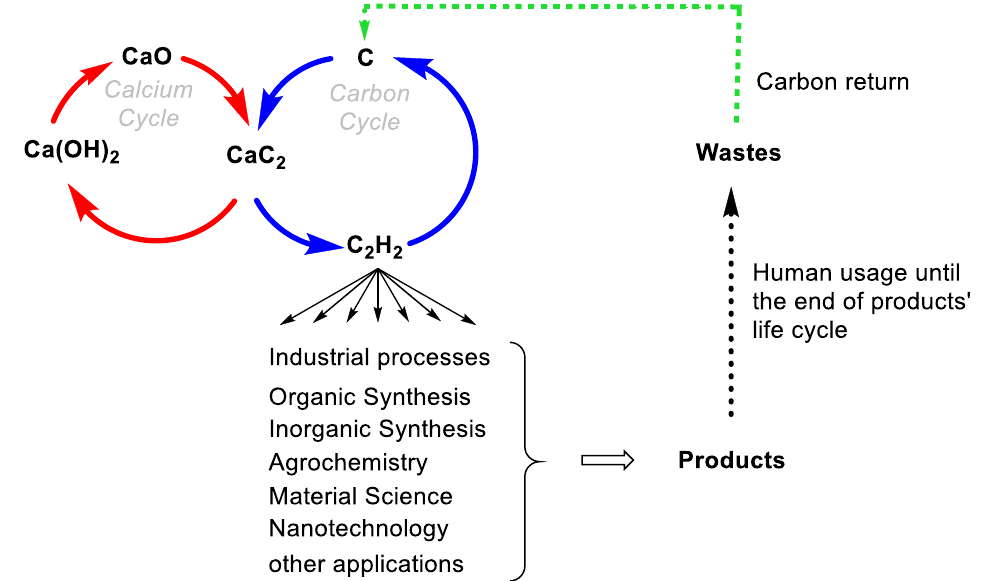
Figure 2. Closing loops for sustainable carbon recirculation.